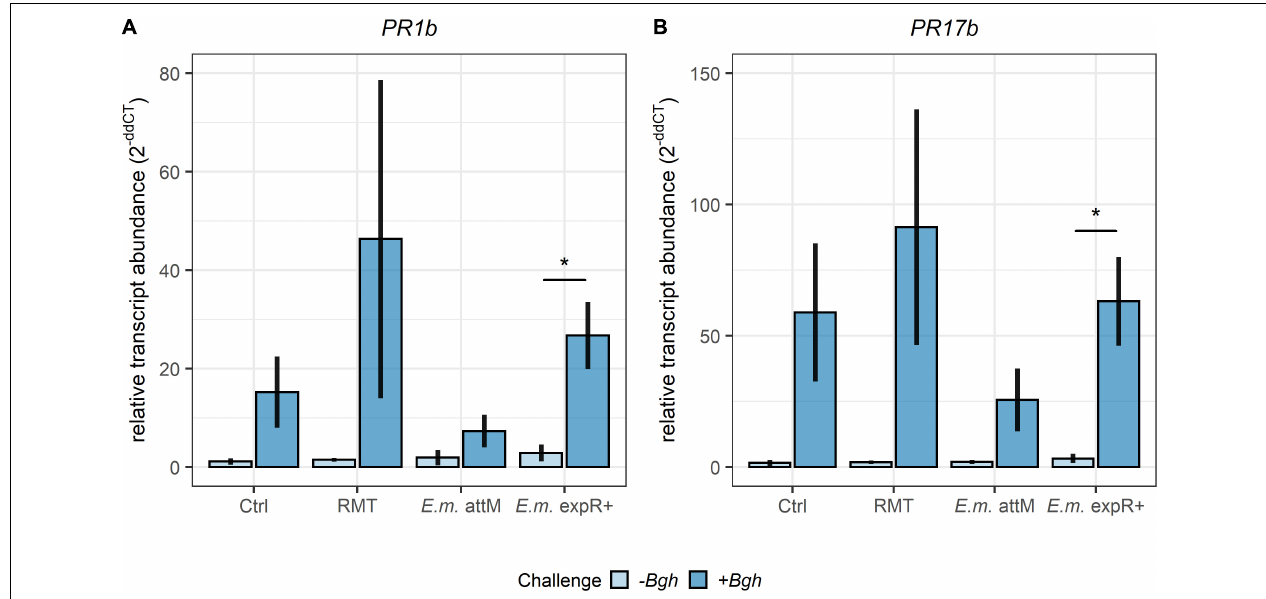
FIGURE 3 | Higher relative transcript abundances of defense-related genes after Bgh challenge of barley treated with the rhizosphere microbiome transplant. Relative transcript abundances measured by qRT-PCR of the defense-related genes (A) PR1b and (B) PR17b in barley leaves 24 h after Bgh challenge. Barley was treated with the rhizosphere microbiome transplant (RMT), saline (0.3% NaCl) as control (Ctrl) or either of the two E. meliloti ( E.m .) strains expR + and attM. Bars represent the mean ± SE of three individual experiments (with each n = 3 per treatment). Transcript abundance was normalized to UBQ transcript abundance and the 0 h time point. Significant differences were tested by Student’s t -test ( p ≤ 0.05).